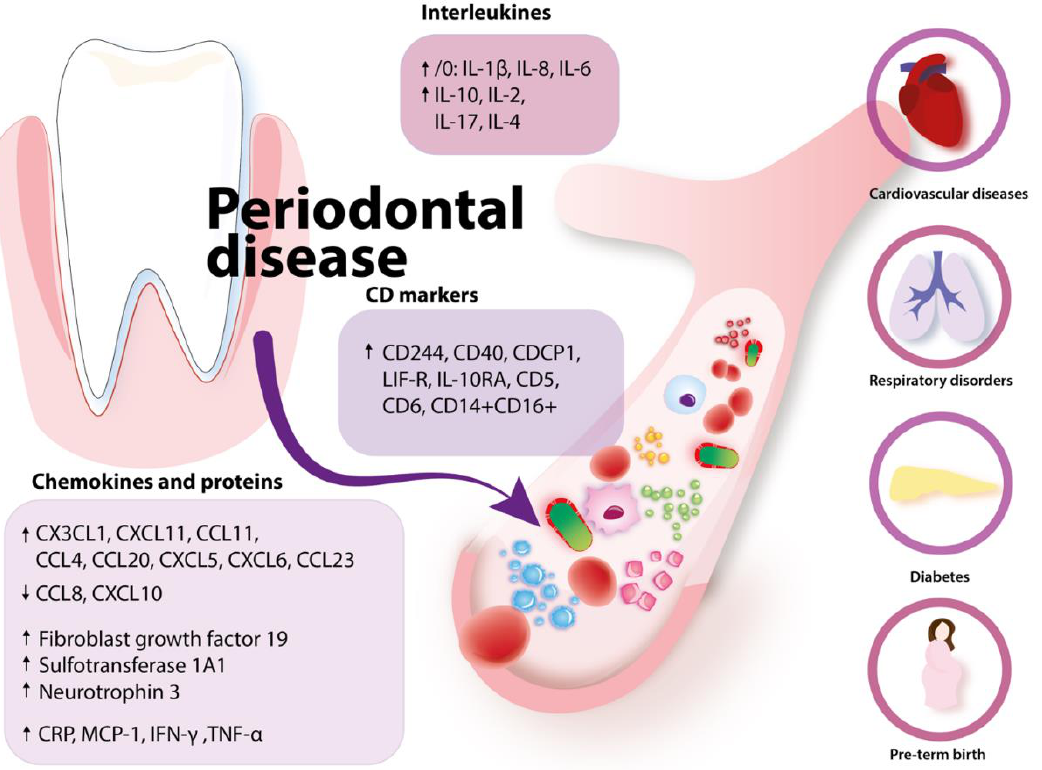
Figure 3. The inflammatory response in periodontal disease and its systemic consequences. The figure illustrates changes in chemokines, proteins, interleukins levels and CD markers present on lymphocytes in the periodontal disease. Inflammatory molecules enter the bloodstream and increases the susceptibility of the organism to systemic diseases like cardiovascular, respiratory, metabolic diseases and pregnancy